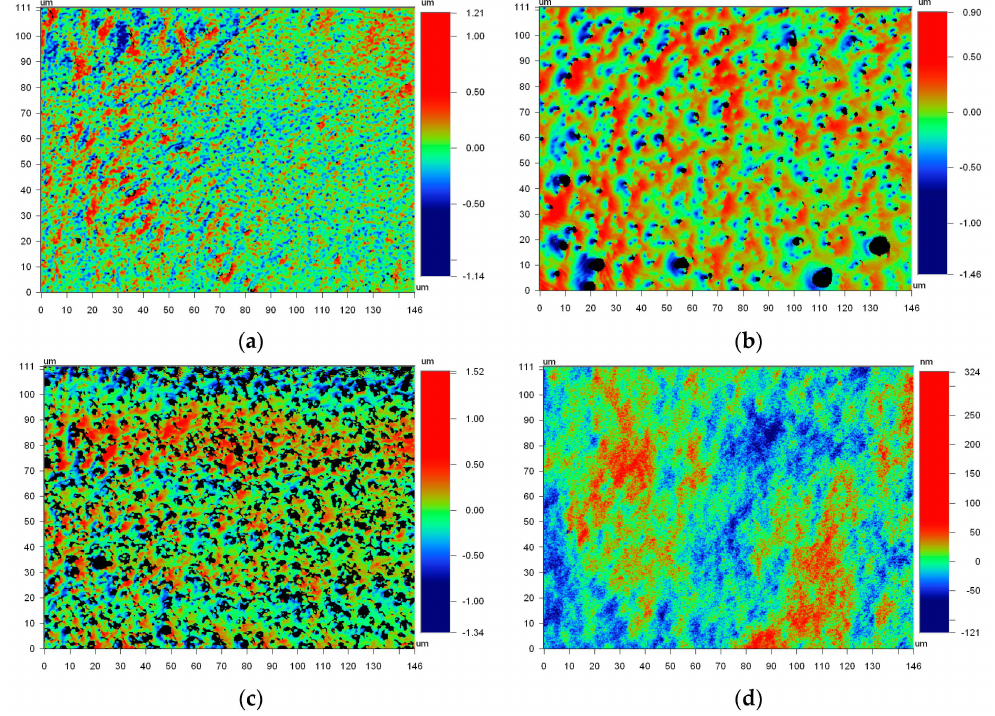
Figure 3. Variation in morphologies of surface striations from ( a ) sample 3, ( b ) sample 4, and ( c ) sample 5; and ( d ) surface morphology of transparent region from sample